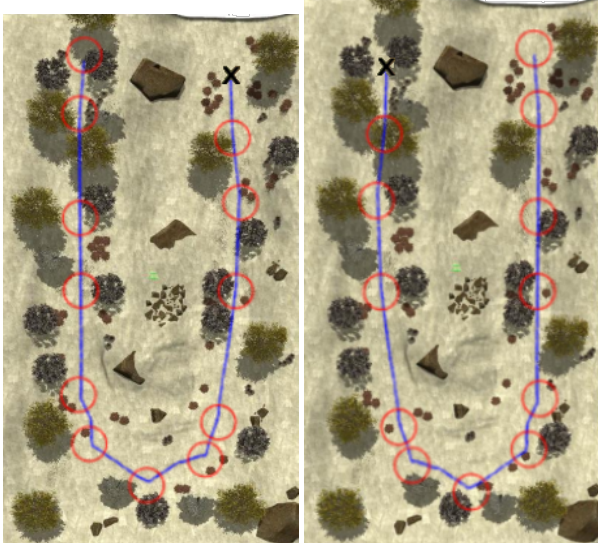
Figure 11. Paths followed during data acquisition in the hillside